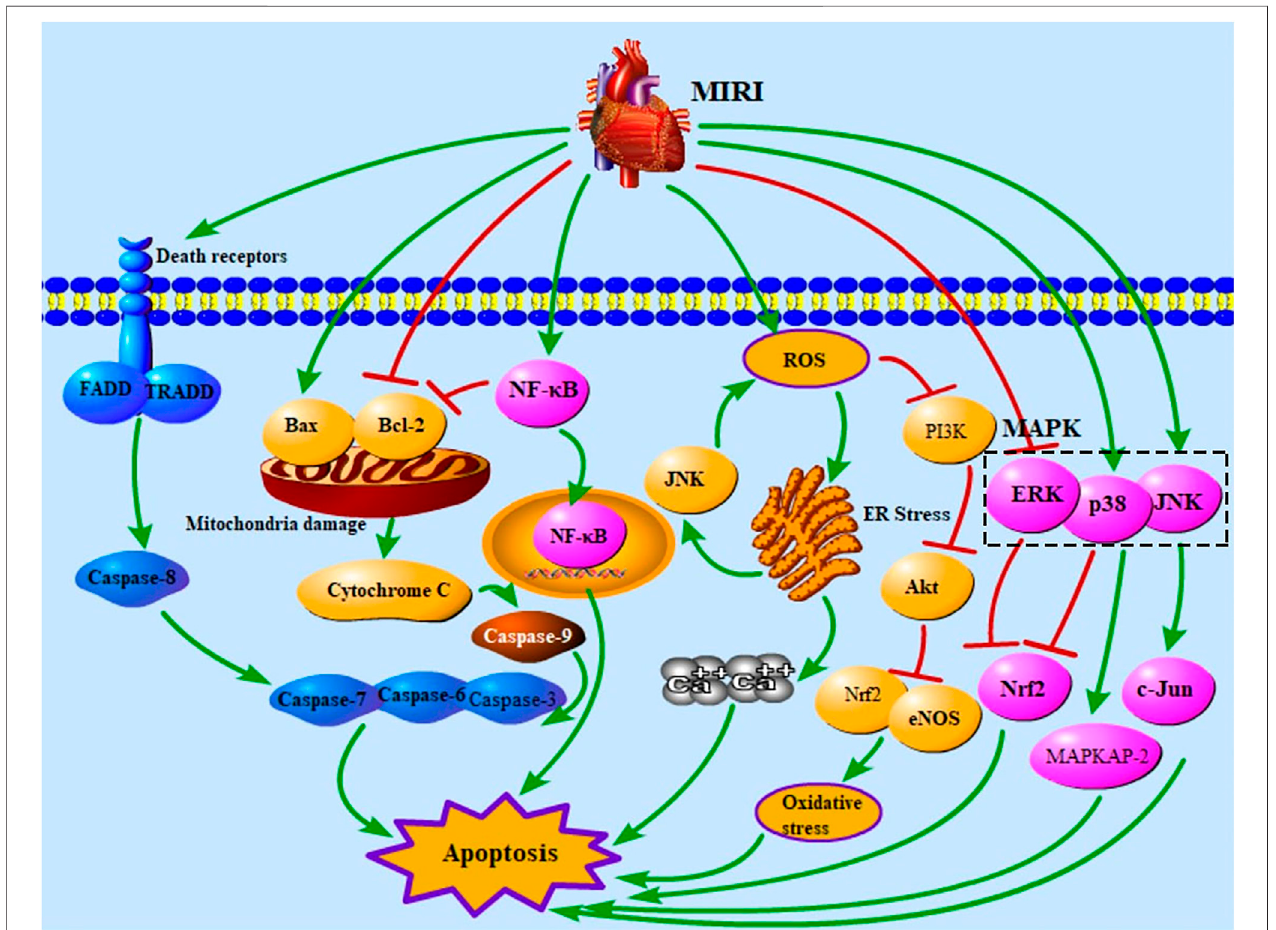
FIGURE 1 | Apoptotic pathways in MIRI. MIRI, myocardial ischemia/reperfusion injury; FADD, Fas-associated death domain protein; TRADD, TNFR1-associated death domain protein; NF- κ B, nuclear factor of kappaB; ROS, reactive oxygen species; ER, endoplasmic reticulum; PI3K, phosphatidylinositol-3-kinase; MAPK, mitogen-activated protein kinase; ERK, extracellular signal – regulated kinase; Nrf2, nuclear factor E2 – related factor 2; eNOS, endothelial nitric oxide synthase; c-Jun, c-Jun N-terminal kinase; MAPKAP-2, MAPK-activated protein kinase-2.